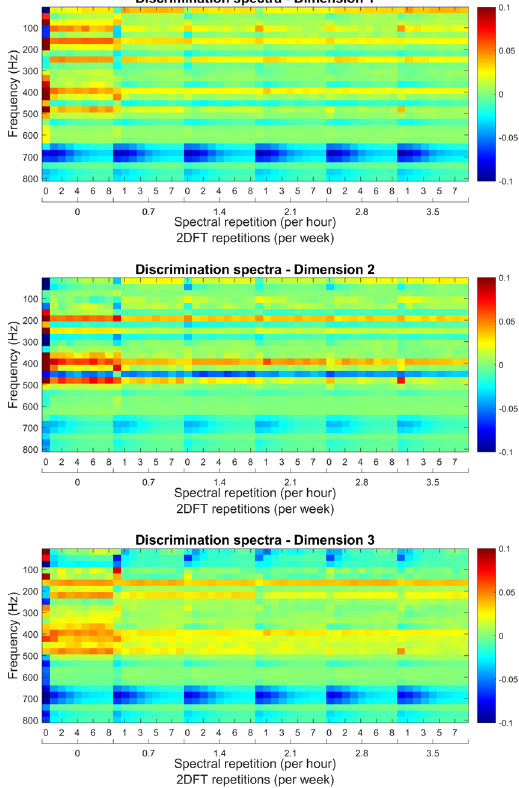
Figure 5. The three discrimination spectra for the spectral evolution algorithm. The pixel colour indicates the negative (blue), positive (red) or zero (green) contribution the user must give to a particular part of the vibrational 3DFT in order to get the first (top), second (middle) or third (bottom) DF score. The frequency components of the FFT of the 2DFTs are shown stacked from left (0 repetitions per week) to right (3.5 repetitions per week) for ease of viewing. This figure was created using the MATLAB (R2018b) software (uk.